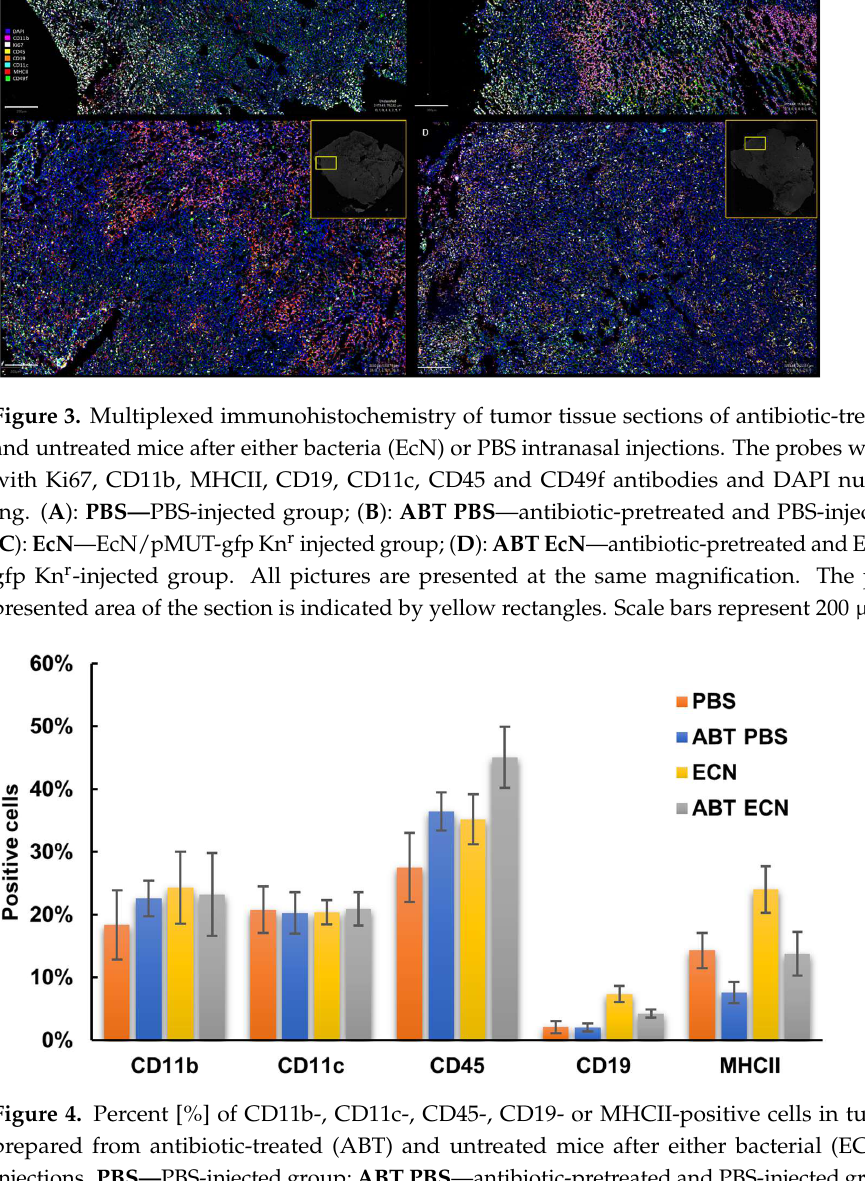
. Figure 5. Percent [%] of dendritic cells (DCs) in tumor tissue prepared from antibiotic-treated (ABT) and untreated mice after either bacterial (ECN) or PBS treatments. PBS—PBS-injected group; ABT PBS—antibiotic-pretreated and PBS-injected group; EcN—EcN/pMUT-gfp Kn r -injected group; ABT EcN—antibiotic-pretreated and EcN/pMUT-gfp Kn r -injected group. Data are representative of three independent experiments ( n = three mice per group). The statistical significance was calculated by the Student’s t-test where * indicates p < 0 .05.